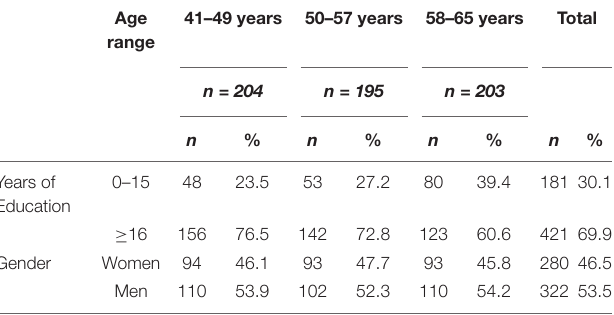
TABLE 1 | Frequencies of demographic characteristics of a validation sample.